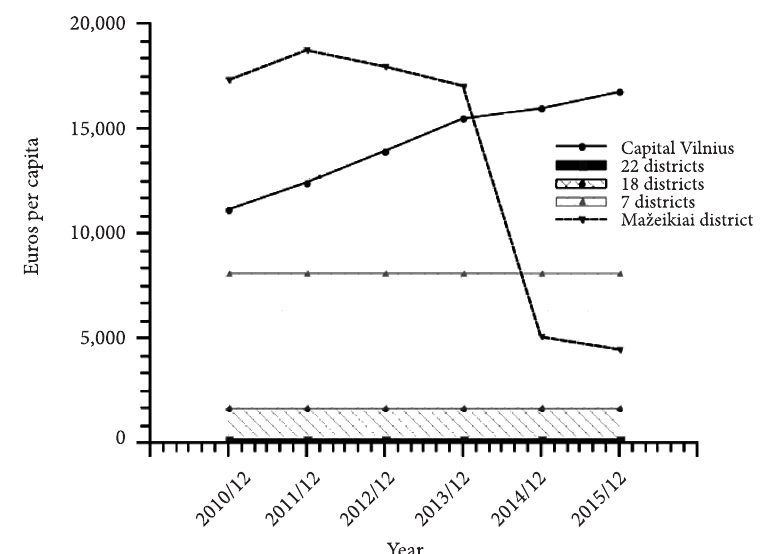
Figure 2. Ranges of the average of FDI per capita in District Municipalities and the average of FDI per capita in Vilnius City (made by authors according to Statistics Lithuania,